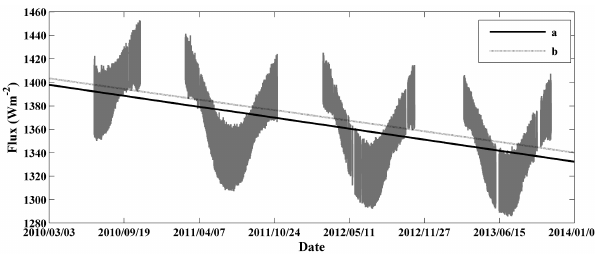
Figure 6. Decrease in the instrument sensitivity as obtained from the global data set (a) and from MES (b) .